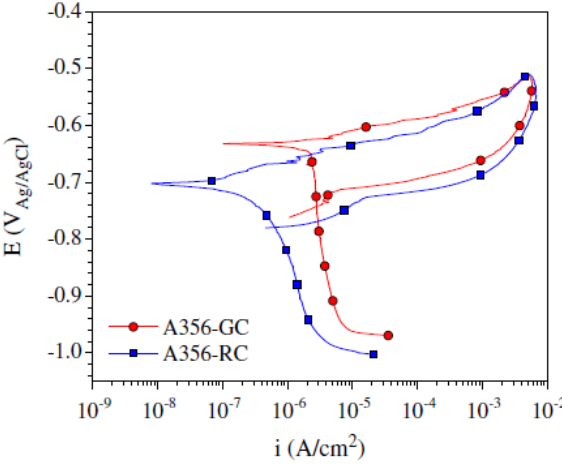
Figure 12. Cyclic polarization curves of A356-GC and A-356-RC aluminum alloys after 1 h immersion in 3.5% NaCl naturally aerated solution. Reprinted with permission of [41].